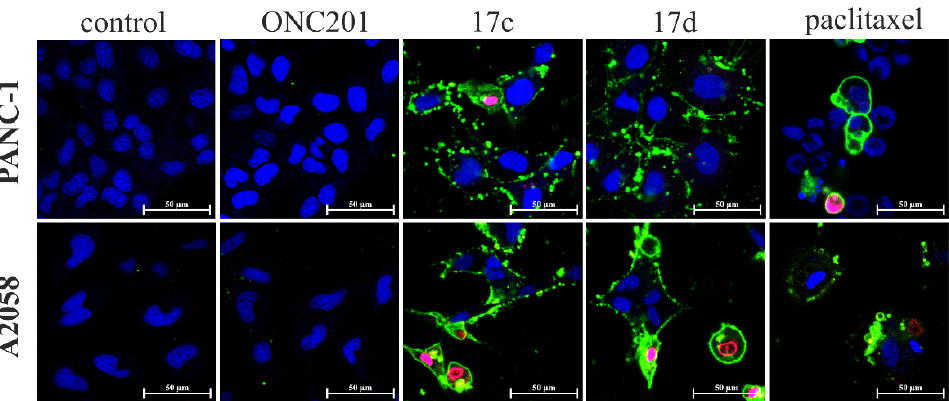
Figure 5. Apoptosis–necrosis detection assay on PANC-1 and A2058 cancer cells by confocal laser